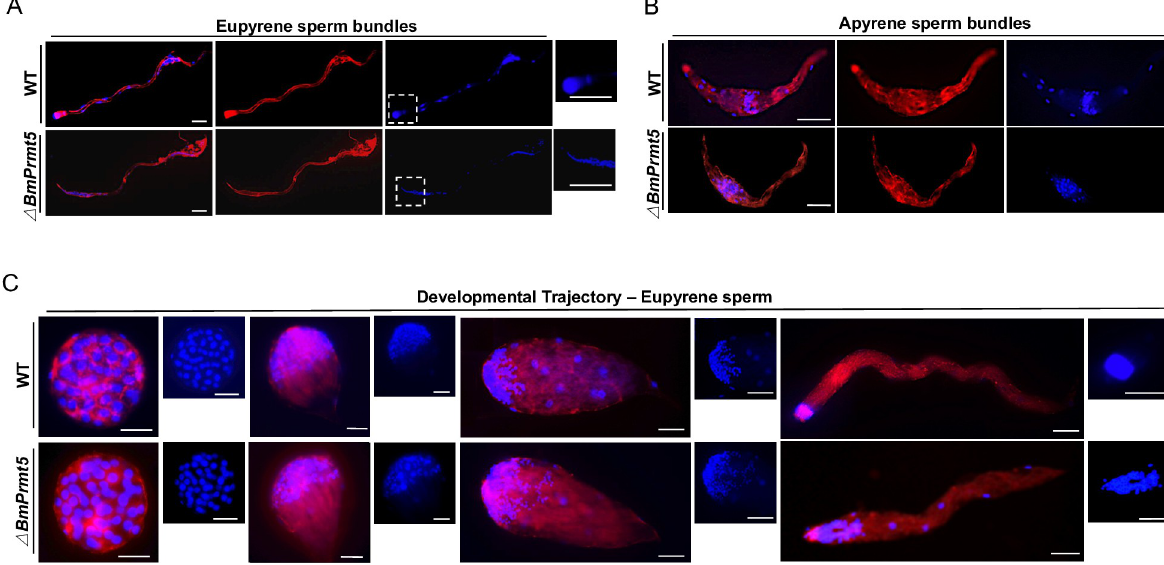
Fig 2. Loss-of-function of BmPrmt5 leads to defects in spermatogenesis. (A and B) Representative immunofluorescence images of A) eupyrene sperm bundles and B) apyrene sperm bundles from WT and BmPrmt5 mutants on the seventh day of the pupal stage. Scale bars, 50 μ m. Eupyrene sperm head are highlighted in dash boxes. (C) Representative immunofluorescence images of the development trajectory of eupyrene sperm bundles from WT and BmPrmt5 mutants at day four of the fifth larval instar. Blue, Hoechst; Red, F-actin. Scale bars, 50 μ m. Δ BmPrmt5 represents BmPrmt5